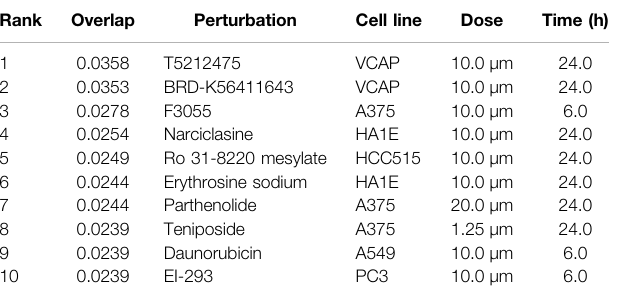
TABLE 10 | Top small molecules identi fi ed by the L1000CDS2 query that reverse the Neuro-COVID vs. IIH-TcMeta gene